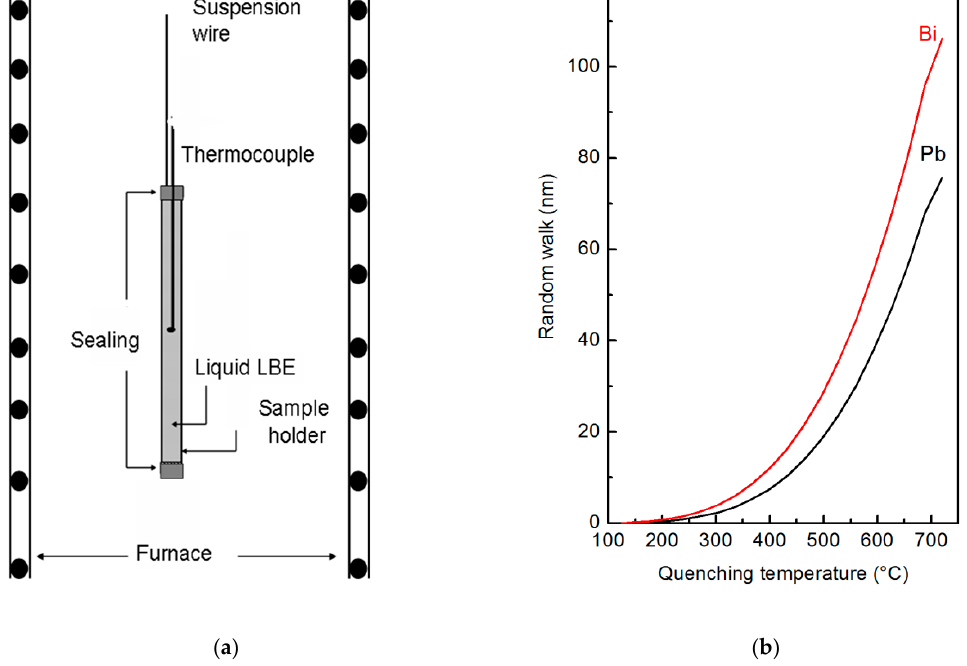
Figure 1. Sketch of the experimental set-up used for quenching liquid lead-bismuth eutectic (LBE) alloy ( a ) and random walk of Bi and Pb atoms in liquid LBE vs. the quenching temperature ( b ).